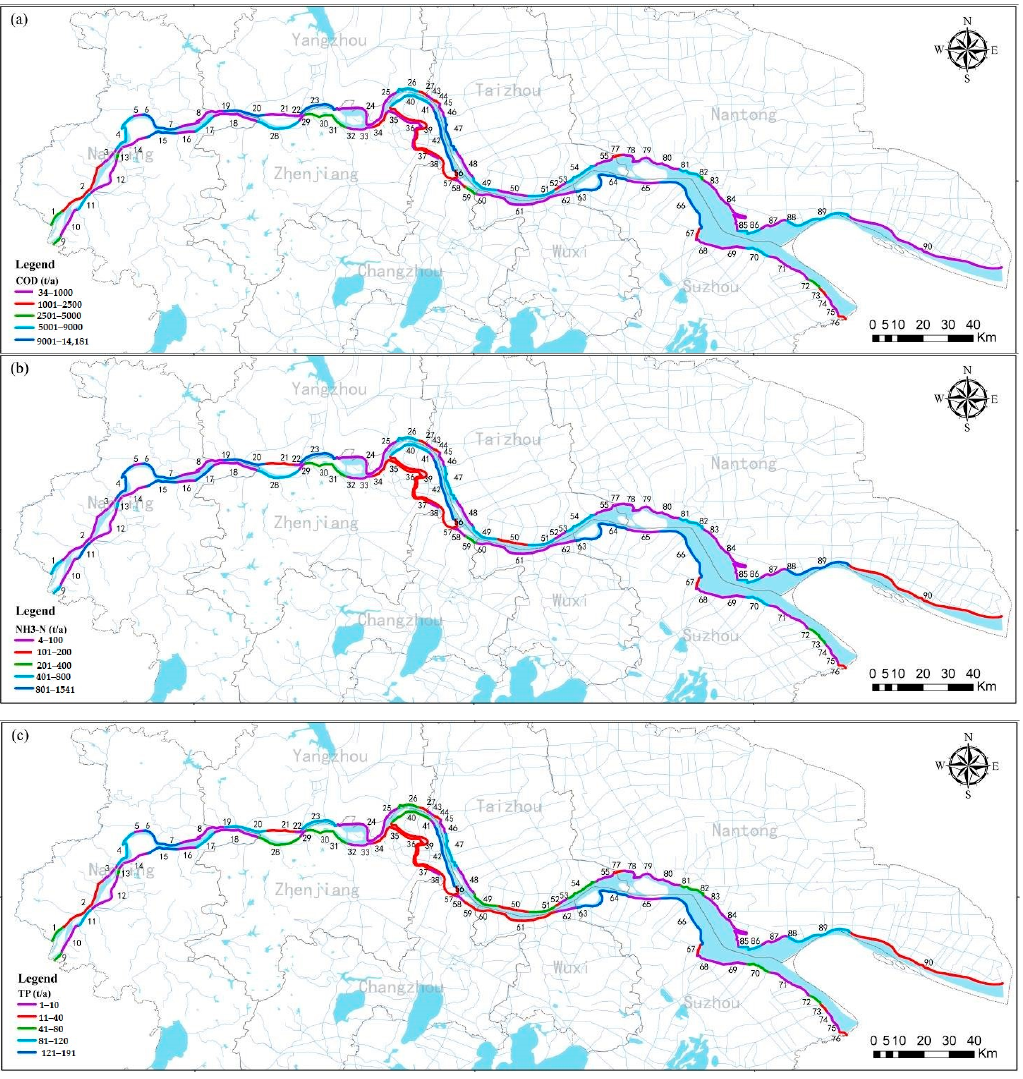
Figure 5. Water environmental capacity (WEC) of 90 water environmental function zones: ( a ) Chemical oxygen demand (COD); ( b ) Ammonia nitrogen (NH 3 -N); ( c ) Total phosphorus (TP).